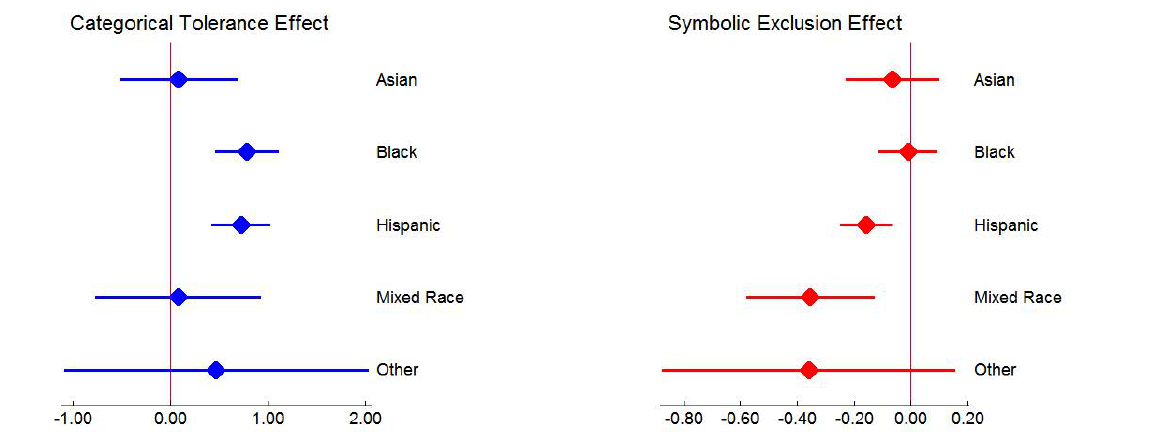
Figure 5: Regression plot (Jann 2014) of coefficient estimates for binary ethnoracial predictors for binary (blue marker, lefthand side) and count (red marker, righthand side) components of zero-inflated Poisson models predicting number of dislikes in